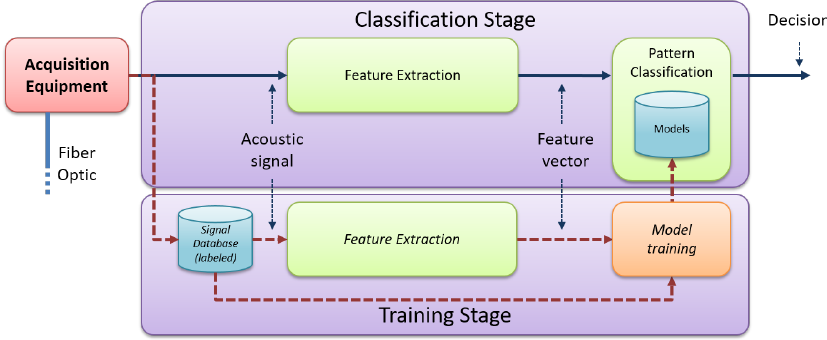
Figure 1. Standard architecture of a DAS+PRS (adapted from